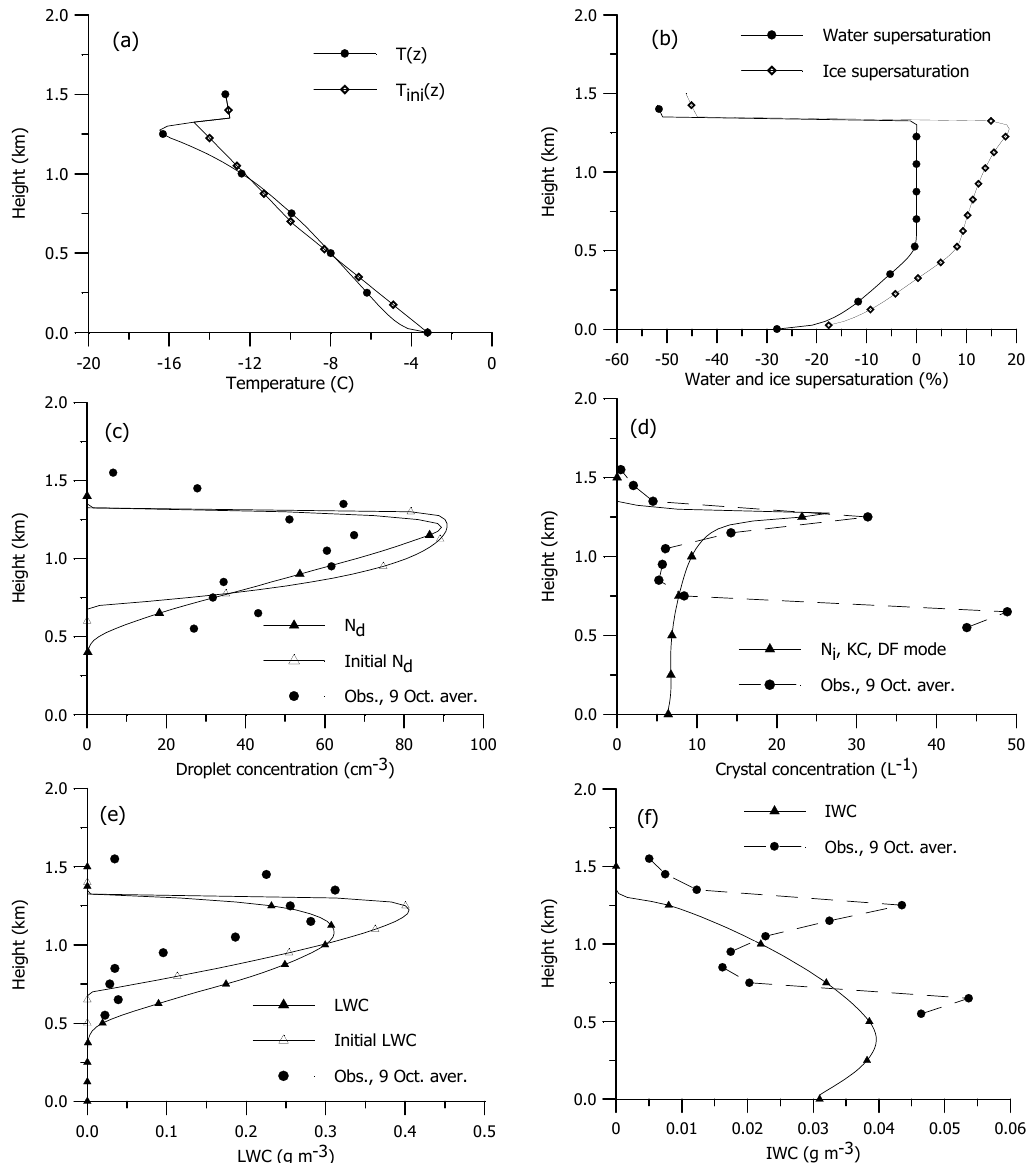
Fig. 8. Vertical profiles of N d , N i , LWC, and IWC for simulations of MPACE on 10 October 2006, corresponding to the time t = 3h in cross-sections in Fig. 7, compared to the observational data for 9 October. KC ice nucleation scheme was used with account for DHetF mode, and KC06-07 CCN activation scheme was used for drop nucleation. In this simulation, the aerosol of the fine observed lognormal mode ( N a1 = 72 . 2cm − 3 , r m = 0 . 052µm, σ 1 = 2 . 04) was allowed to serve as CCN; the aerosol of the coarse observed lognormal mode ( N a2 = 1 . 8cm − 3 , r m = 1 . 3µm, σ 2 = 2 . 5) was allowed to serve as ice nuclei. Note a pronounced maximum in N i at ∼ 1.25km, both in simulations and observations, that coincides with the temperature minimum − 16 to − 16.5 ◦ C, where a substantial increase in ice nucleation rate is predicted by KC theory (KC04,